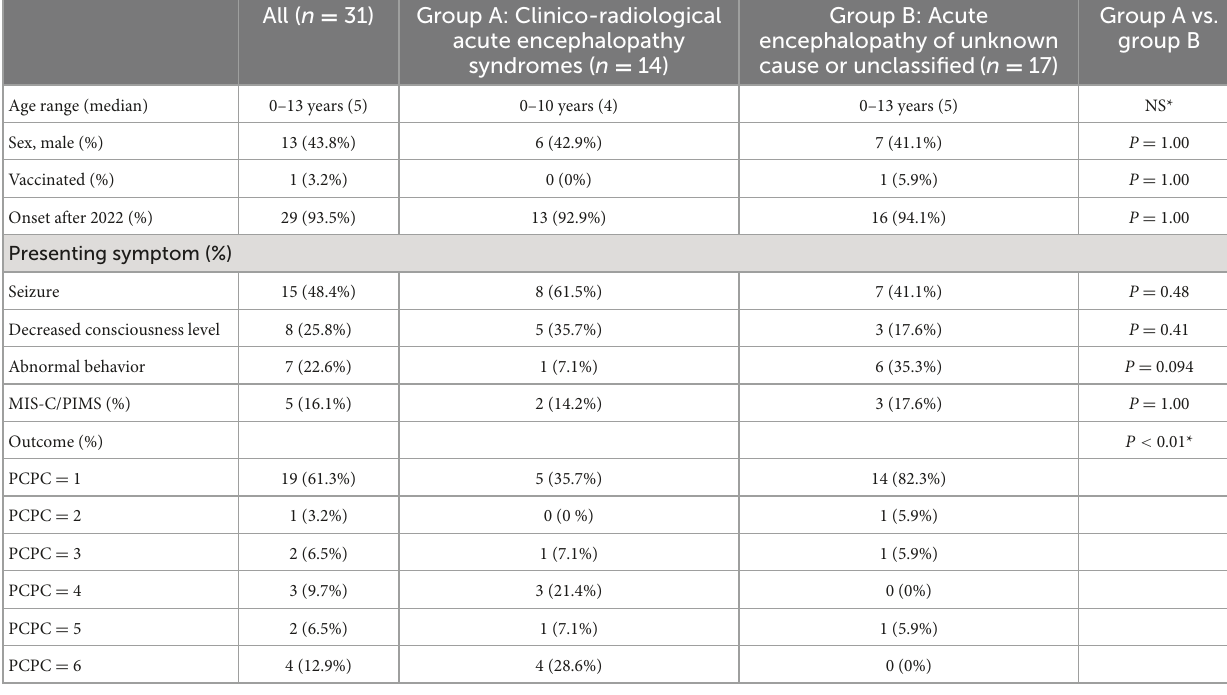
TABLE 1 Characteristics and outcomes of pediatric patients with COVID-19-related acute encephalopathy. All ( n = 31) Group A: Clinico-radiological Group B: Acute acute encephalopathy encephalopathy of unknown syndromes ( n = 14)